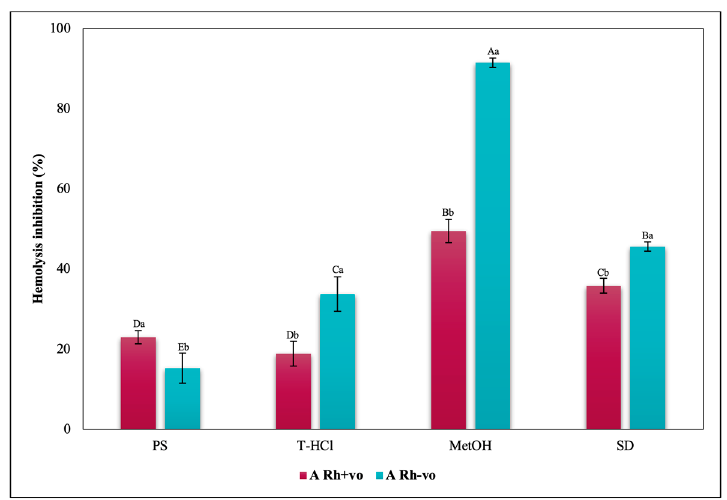
Figure 18. Inhibitory effect of heat-induced hemolysis of P. cruentum extracts on human erythrocytes with different RhD (positive and negative) of A blood group. Different letters represent significant differences in the means between treatments and groups ( p ≤ 0.001). Capital letters represent a two- way ANOVA. Lowercase letters represent a univariate ANOVA between the extracts. PS, extract of physiological solution; T-HCl, 0.5 M Tris-HCl extract; MetOH, 99% methanol extract; SD, sodium diclofenac.